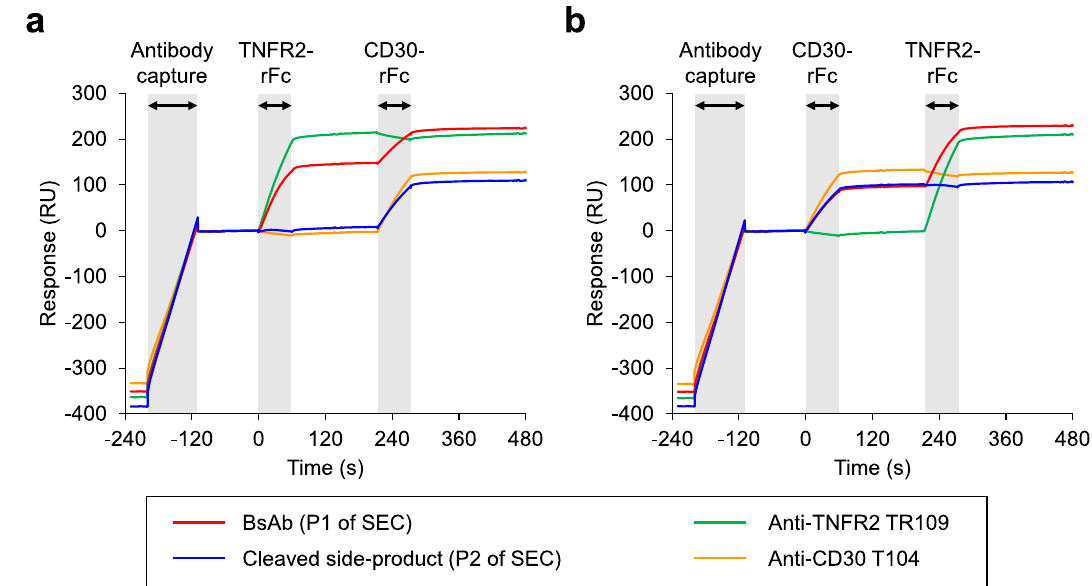
Figure 3. Interaction of the antibodies captured on a sensor chip with recombinant antigen proteins analyzed by surface plasmon resonance. ( a ) TNFR2-rFc and CD30-rFc as the 1st and 2nd analytes, respectively. ( b ) CD30-rFc and TNFR2-rFc as the 1st and 2nd analytes,